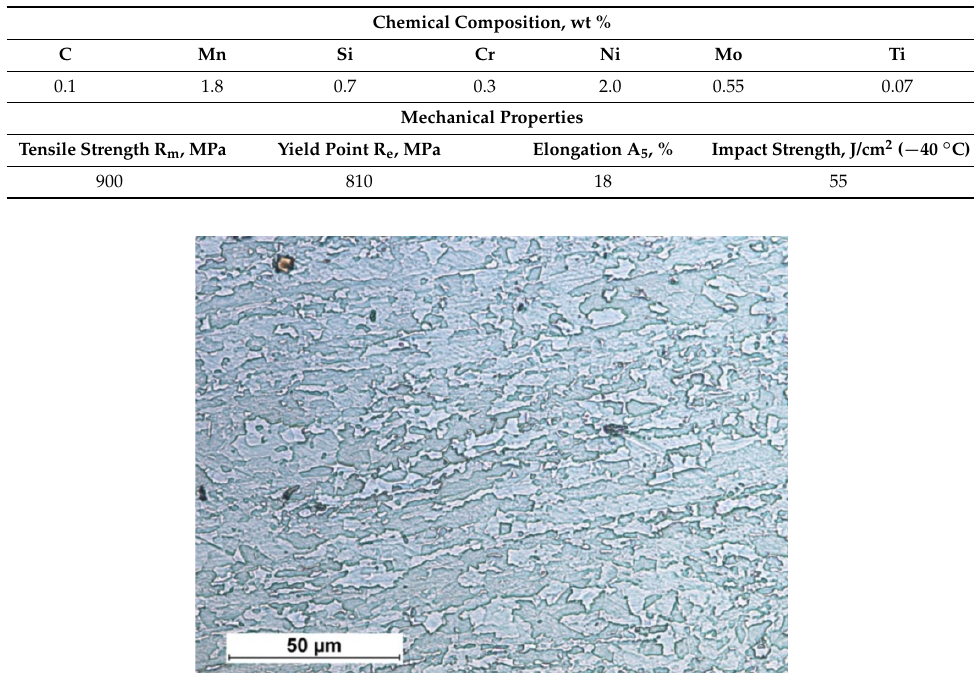
Table 2. Chemical composition and mechanical properties of filler metal GMn4Ni1.5CrMo.